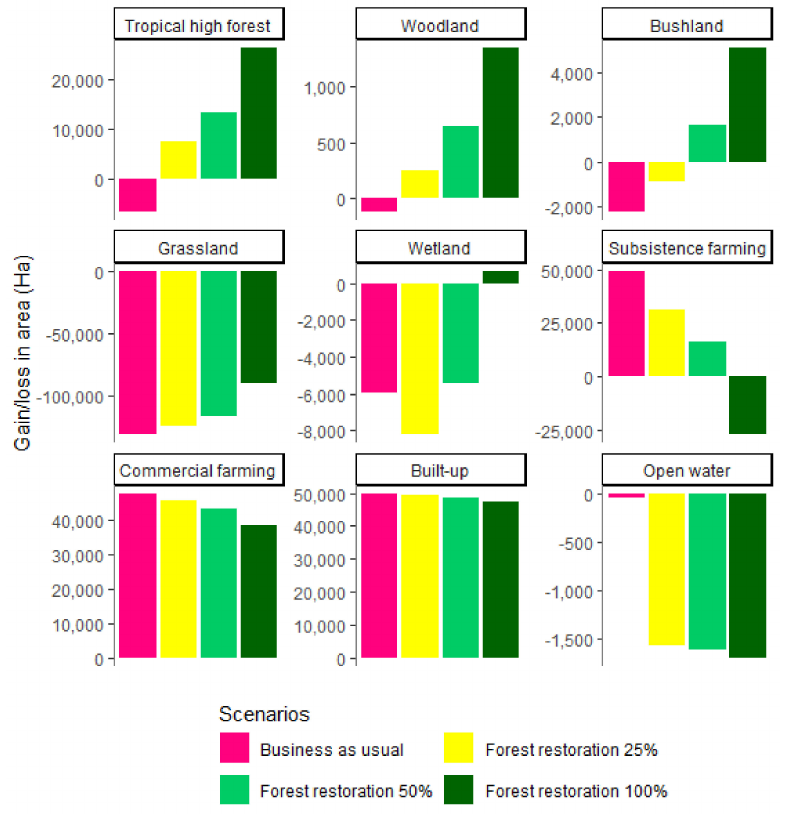
Figure 5. Predicted LULC gain and loss for Budongo–Bugoma landscape under different